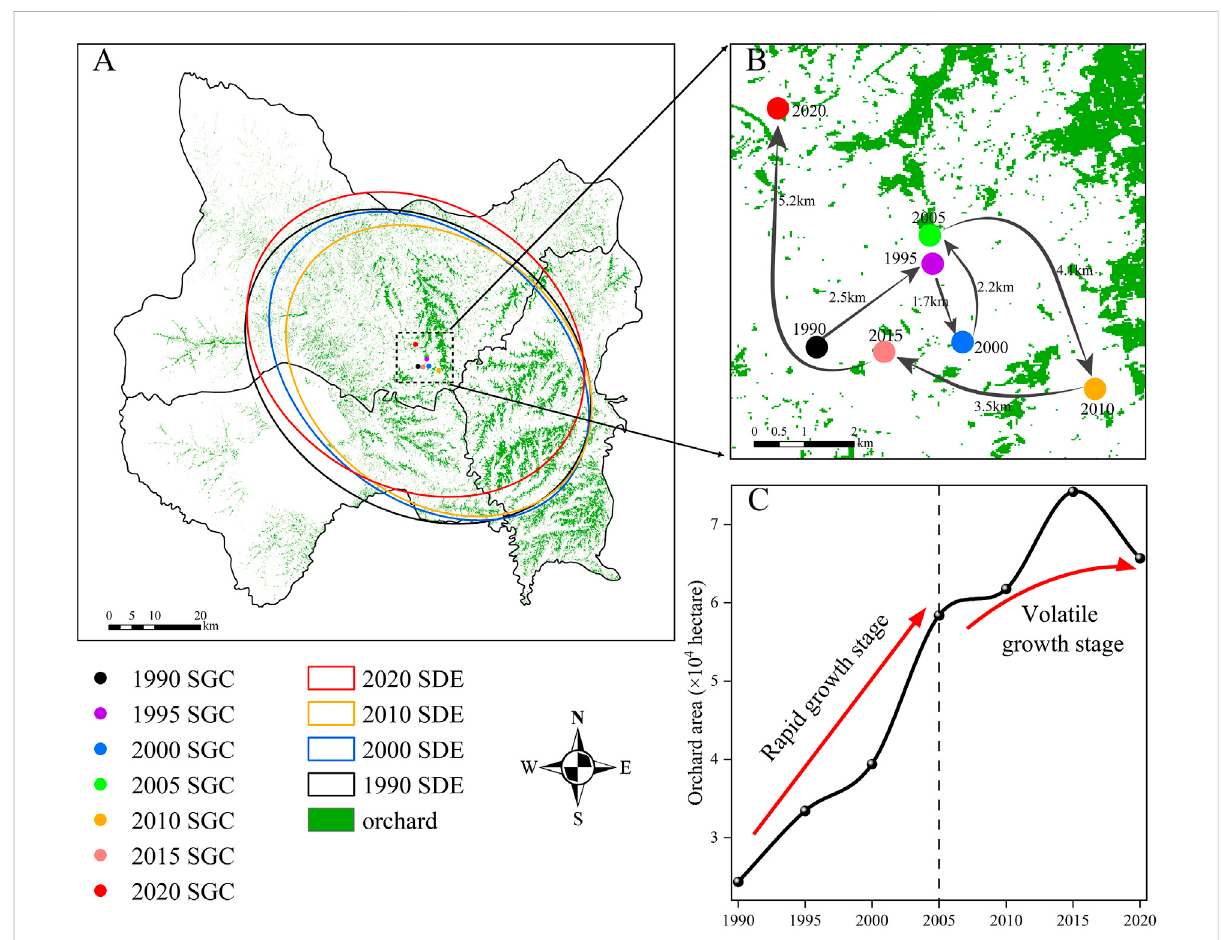
FIGURE 7 Standard deviation ellipse (SDE) analysis and total area growth of orchard. (A) The SDE and its SGC of orchard from 1990 to 2020. The ellipse represents the gathering direction. (B) Shift in SGC and its shifting distance. (C) Growth trend of orchard area in the study area and two stages were divided according to its growth